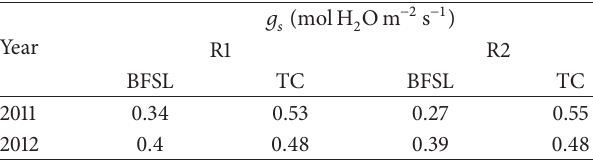
Table 3: Mean 𝑔 𝑠 at growth stages R1 and R2 of 10 irrigated maize hybrids grown on a Bosket fine sandy loam (BFSL) and a Tunica clay (TC) soil in 2011 and 2012 near Stoneville, MS †